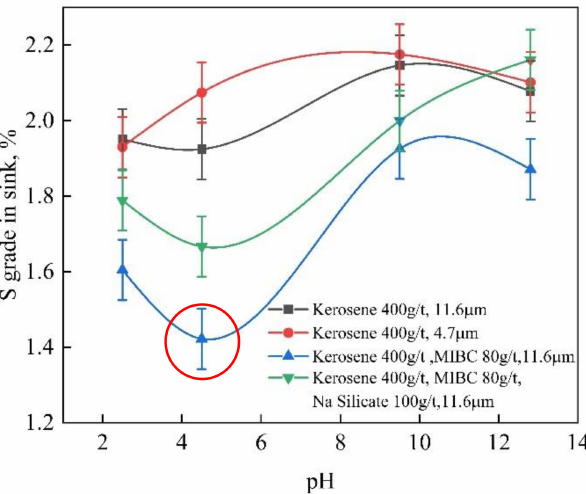
Figure 9. Sulfur grades in sink products of flotation using only kerosene for shungite of 4.7 µ m and flotations using only kerosene, MIBC + kerosene, and MIBC + sodium silicate + kerosene for shungite of 11.6 µ m mean